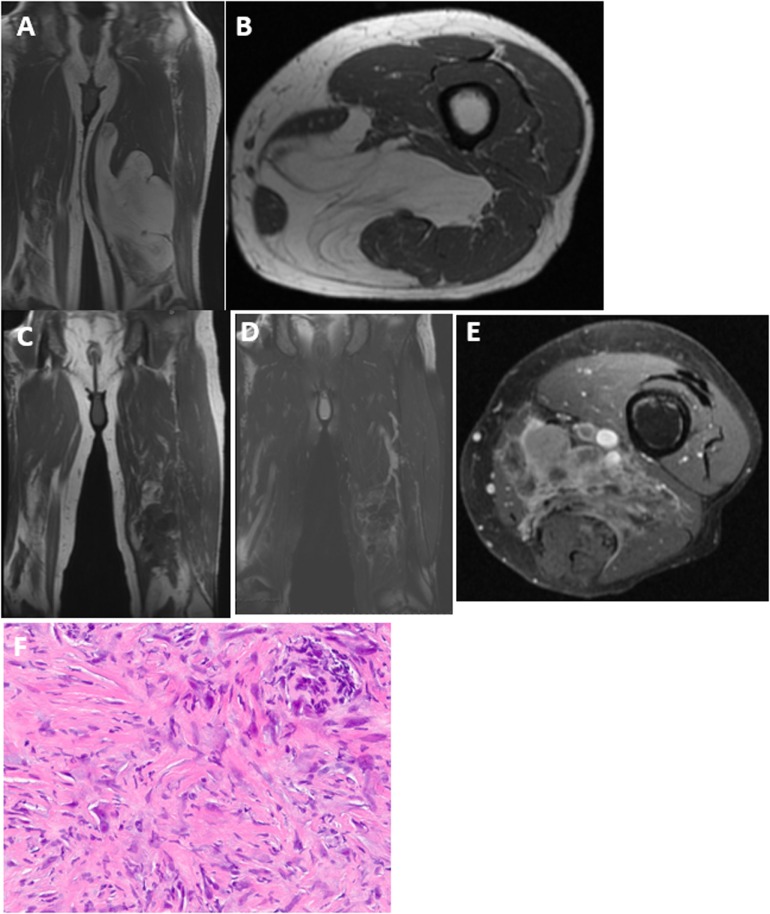
Upon initial presentation, (A) coronal and (B) axial T1 MRI showed a large deep-seated lipomatous mass within the medial thigh. The majority of the mass is lipomatous with some septations consistent with an ALT, which was confirmed on histology. Seven years following resection, MRI now shows a heterogenous lesion within the same region with very little fat signal that is dark on T1 (C) with intermediate signal on T2 (D) and enhances with gadolinium contrast (E). (F) Needle biopsy shows scattered pleomorphic spindle cells confirming the diagnosis of dedifferentiated liposarcoma.